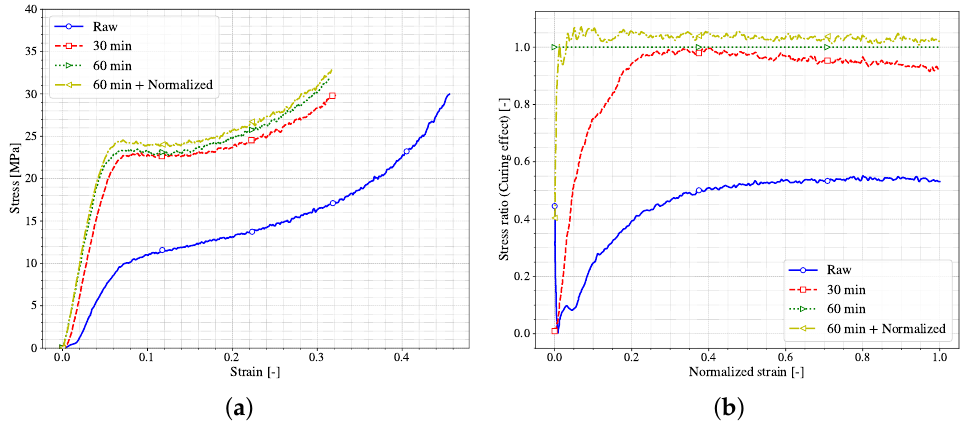
Figure 13. Post-Curing effect on stress-strain curves. ( a ) σ vs. ε ; ( b ) ratio of